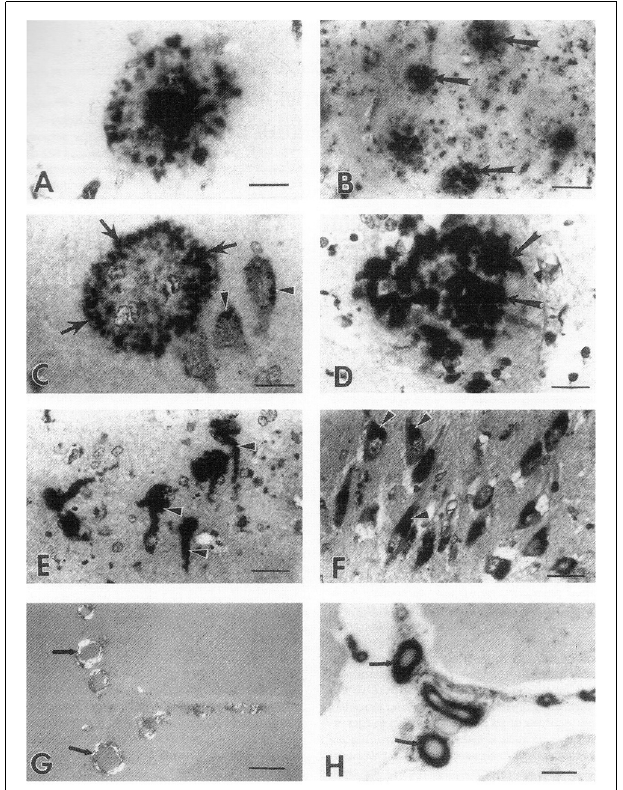
FIGURE 3 | Immunolocalization of heparan sulfate GAGs in neurons and in the characteristic lesions of AD. (A) immunostaining of an amyloid plaque in the hippocampus of a 90-year old woman with AD (obtained 5.5 h after death using the monoclonal antibody (HK-249) recognizing HS GAG chains. Bar, 21 µ m. (B) Immunostaining of primitive plaques (arrows) in the amygdala of a 64-year old man with AD (4 h after death). Bar, 80 µ m. (C) Heparan sulfate GAG immunostaining (HK-249) in the periphery (arrows) of a primitive plaque in the hippocampus of a 90-year old woman with AD (5 h after death). Note HS immunostaining also in the cell bodies of adjacent neurons (arrowheads). Bar, 20 µ m. (D) Strong immunostaining of a primitive plaque using HK-249 antibody in the hippocampus of a 67-year old man with AD (5.5 h after death). Note immunostaining of neurites in plaque (arrows). Bar, 20 µ m. (E) Heparan sulfate GAG immunostaining (HK-249) of neurofibrillary tangles (arrowheads) in the amygdala of a 64-year old man with AD (4 h after death). Bar, 40 µ m. (F) Strong immunostaining in the cell bodies of neurons (arrowheads) using the HK-249 HS GAG chain antibody in the hippocampus of a 90-year old woman with AD (5.5 h after death). These neurons do not contain tangles because on adjacent serial sections they were negative for Congo red staining, Bar, 40 µ m. (G) Positive Congo red staining of meningeal blood vessels (arrows) in the cerebellum of a 74-year old man with AD indicating the presence of cerebrovascular amyloid in these vessels, Bar, 108 µ m. (H) Serial section of tissue shown in (G) demonstrates HK-249 HS GAG